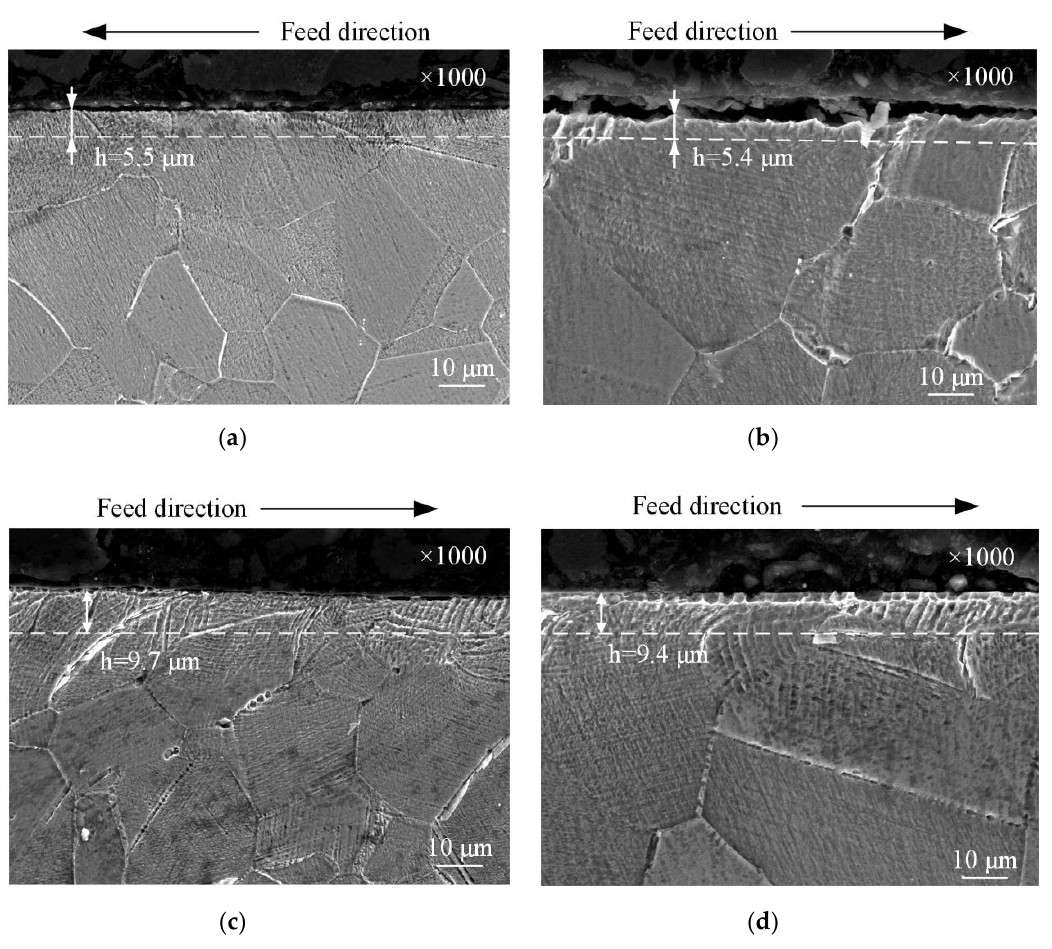
Figure 9. Microstructure of specimens of GH4169 superalloy under different cooling conditions; ( a ) VB = 0.05 mm (wet milling), ( b ) VB = 0.05 mm (dry milling), ( c ) VB = 0.20 mm (wet milling), ( d ) VB = 0.20 mm (dry milling).